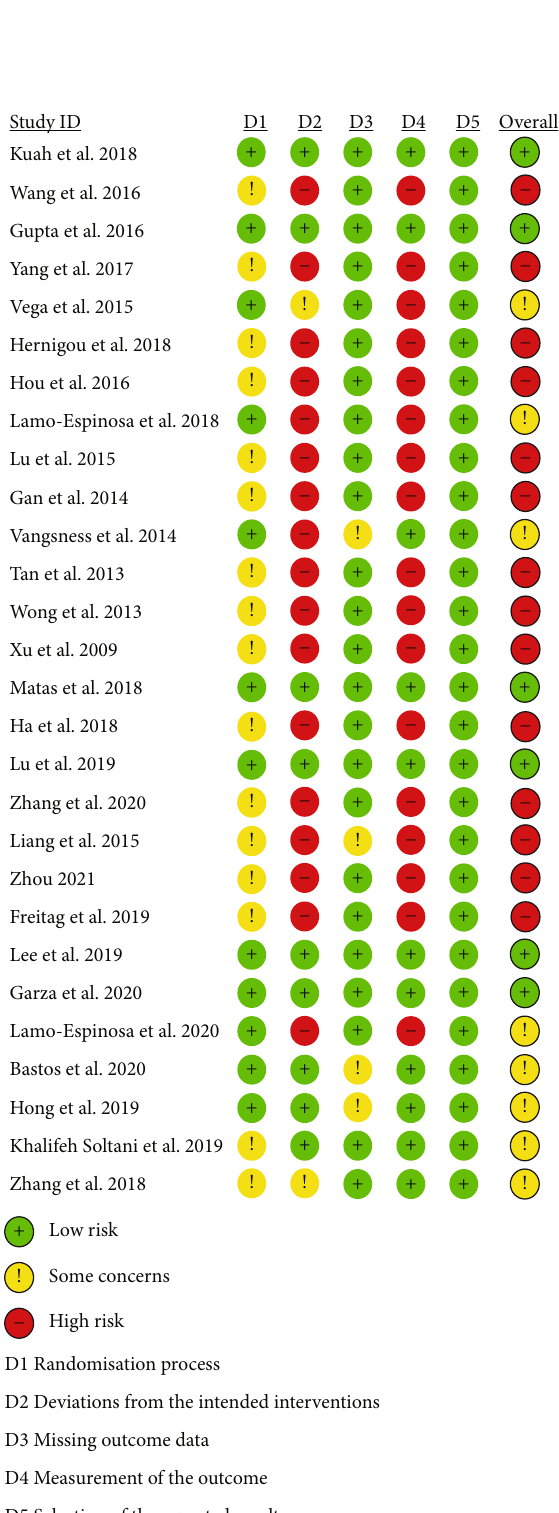
Figure 2: Risk of bias